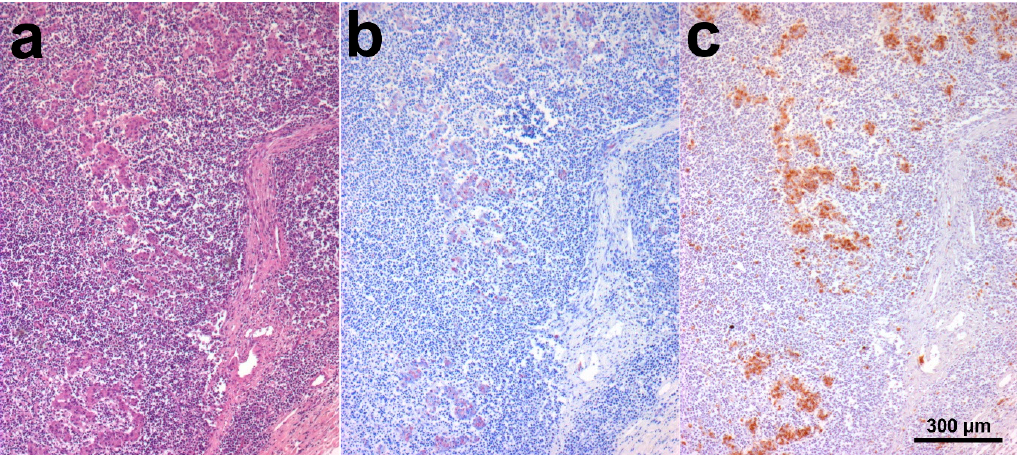
Figure 2. SHO 4, mesenteric lymph node. ( a ) Numerous aggregates of epithelioid macrophages were visible in lymph nodal parenchyma. HE stain; ( b ) A moderate number of AF bacilli were detected within lymph nodal macrophages. ZN stain; ( c ) MAP antigens were moderately highlighted within lymph nodal macrophages. IHC stain.